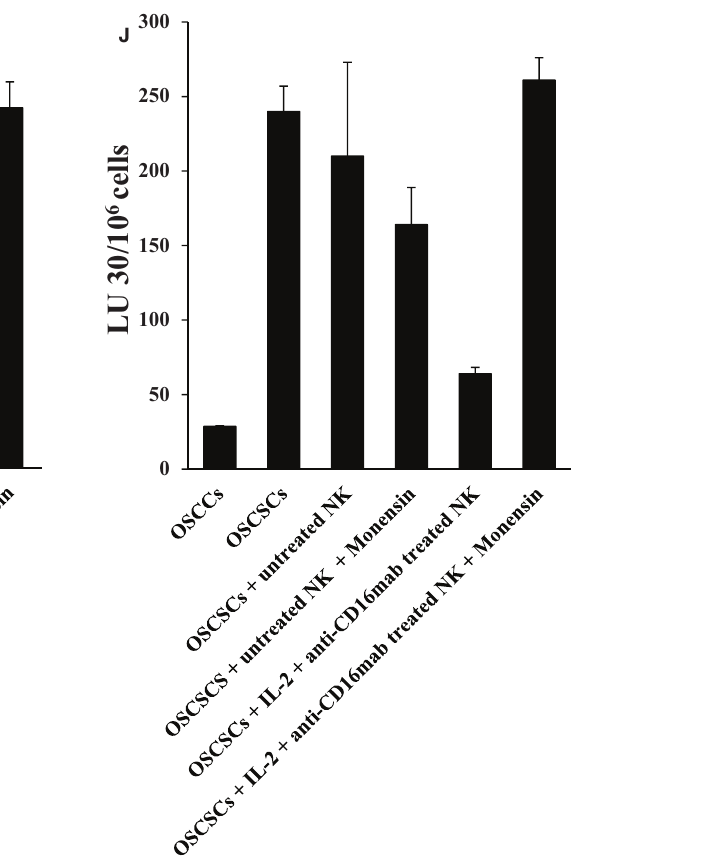
FIGURE 6 | Continued The results were compared to OSCSCs in the absence of fixed NK cells.The media containing the fixed NK cells were removed and extensively washed from each treated OSCSCs and the cytotoxicity against each condition of OSCSCs were assessed using freshly isolated untreated NK cells (I) , those treated with IL-2 (J) or treated with the combination of IL-2 + anti-CD16 mAb (K) using a standard 4h 51 Cr release assay.The complete removal of fixed NK cells from OSCSCs was determined by microscopy. Differentiated OSCCs were used as control for the differentiation of OSCSCs. Percent cytotoxicity was obtained at different effector to target ratio, and the lytic units 30/10 6 cells were determined using inverse number of NK cells required to lyse 30%